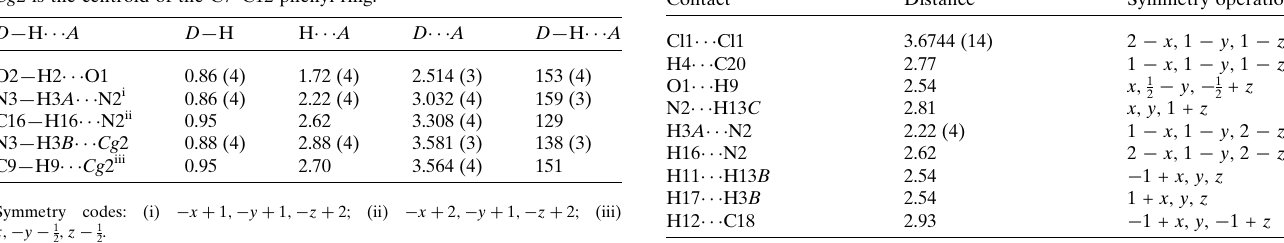
Table 1 Hydrogen-bond geometry (A˚ , (cid:3) ). Cg 2 is the centroid of the C7–C12 phenyl ring.